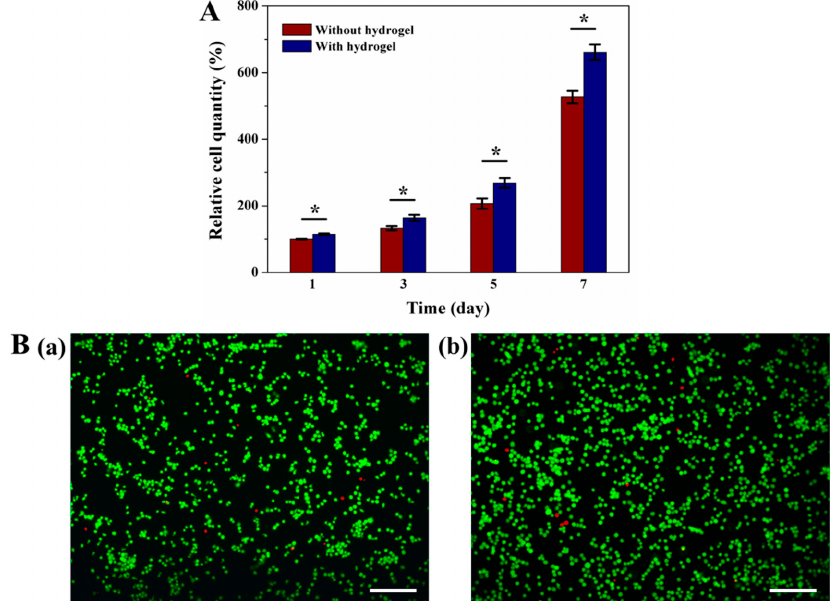
Figure 7. Profiles of hourly wise-stage release of thrombin in human serum with or without CS15 at different triggering times (0 h, 48 h, 96 h, and 144